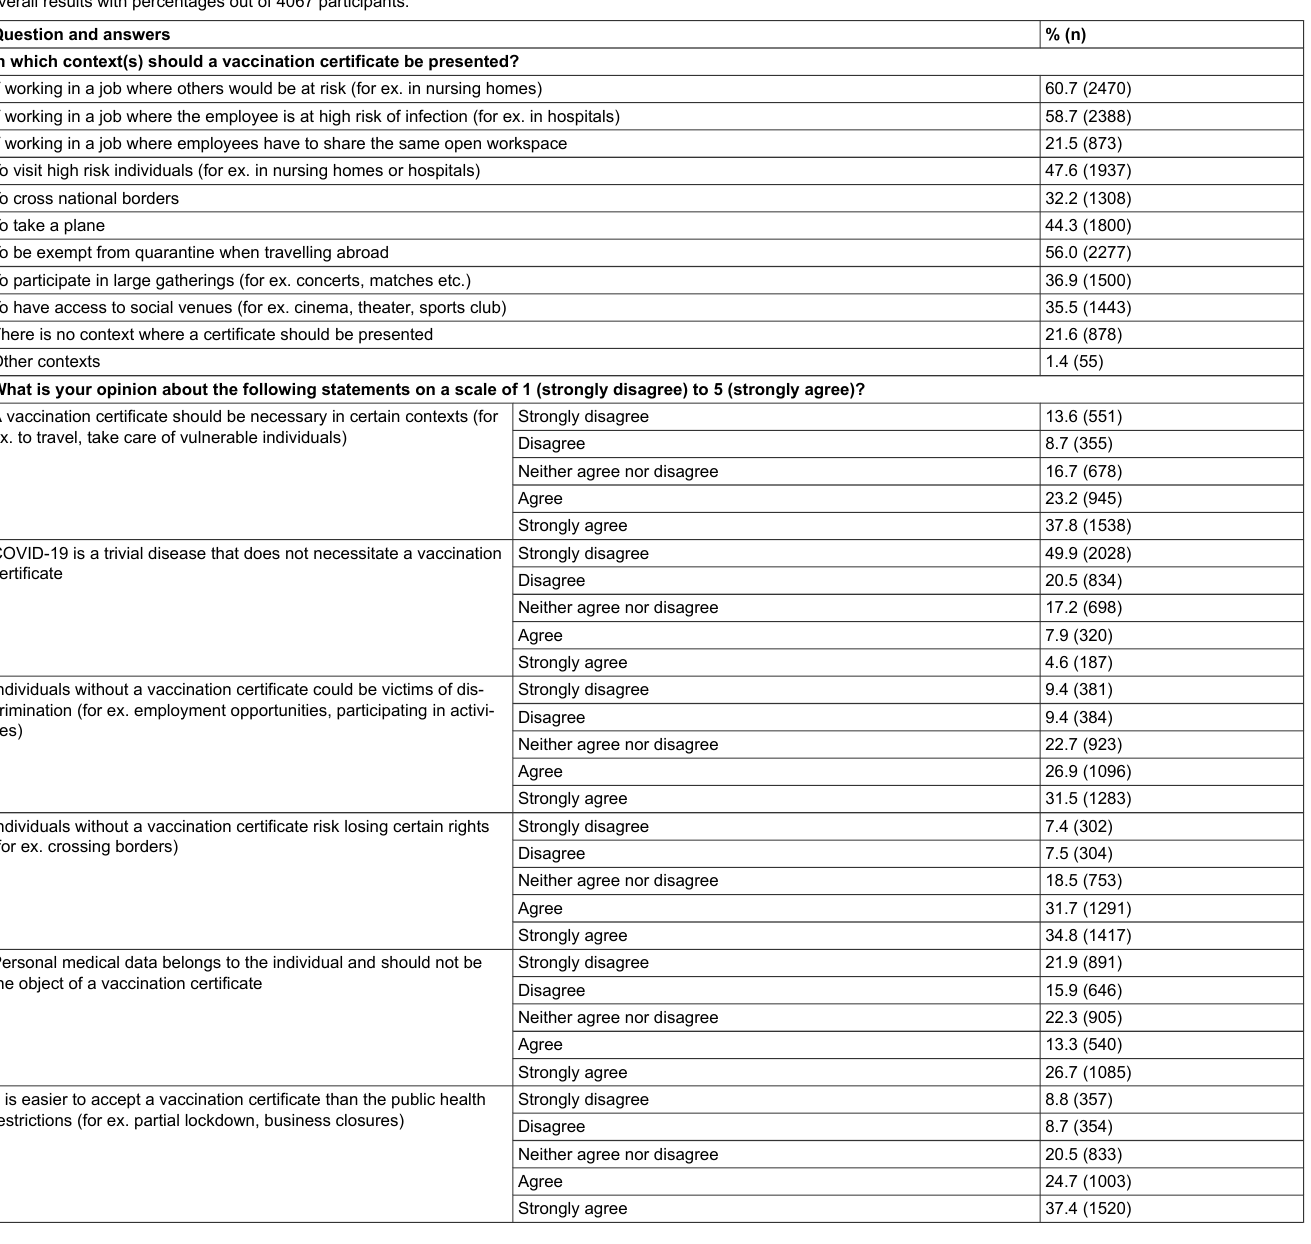
Table 2: Overall results with percentages out of 4067